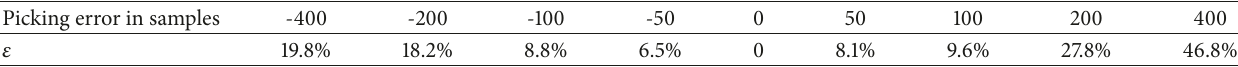
Table 3: Influence of picking